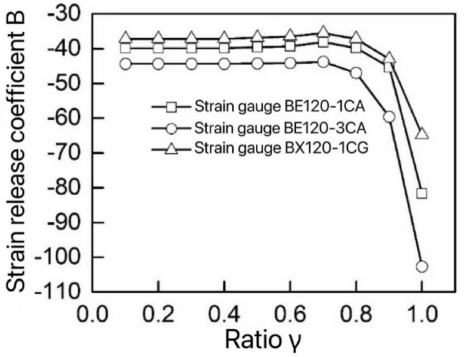
Figure 9. Variation curve of strain release coefficient B with ratio γ of different strain